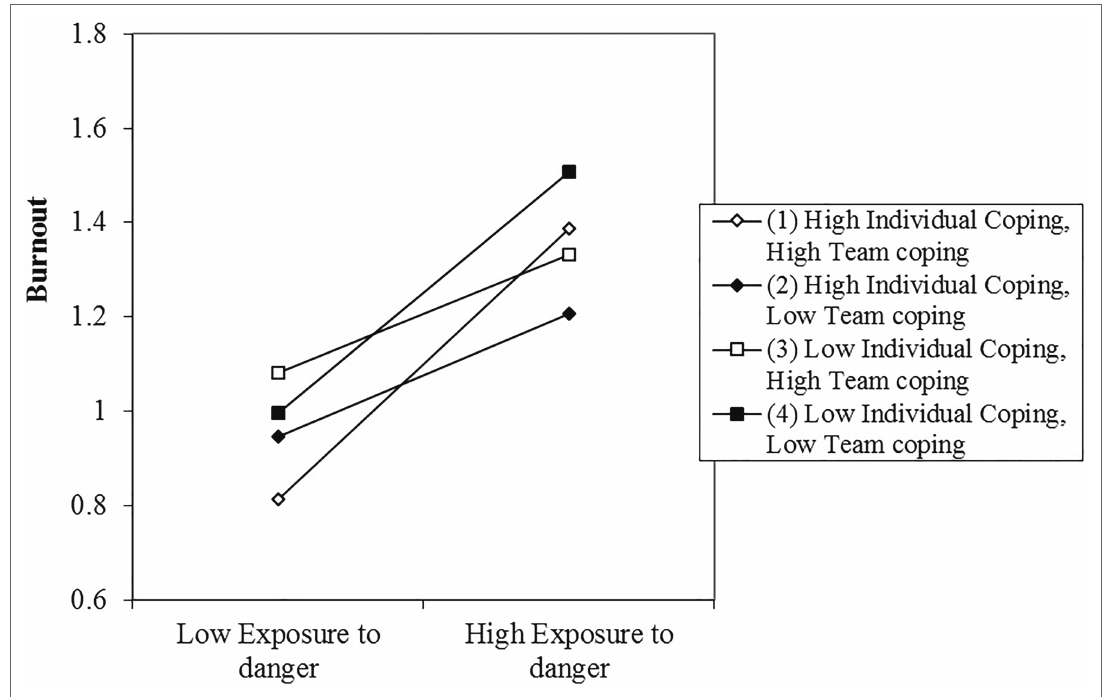
FIGURE 2 | Interactive relation of exposure to danger, individual-level coping, and team-level coping with